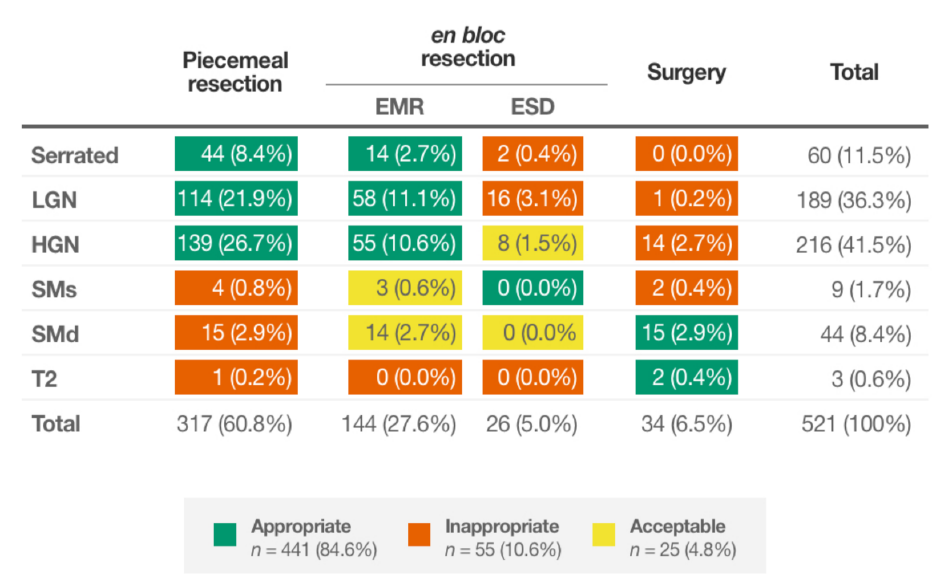
Figure 3. Lesion histology according to the treatment performed in clinical